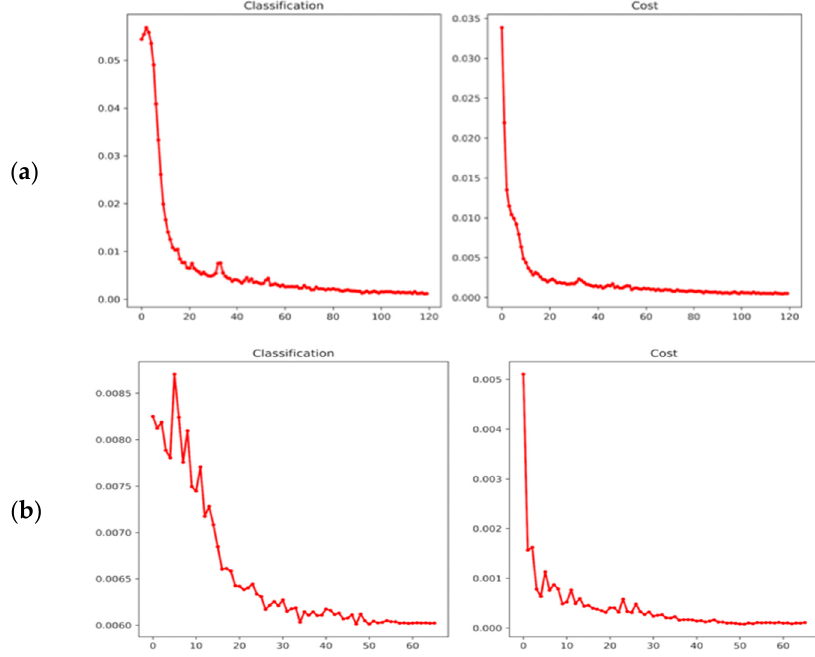
Figure 8. Training curves of ( a ) NEU ( b ) Paint.